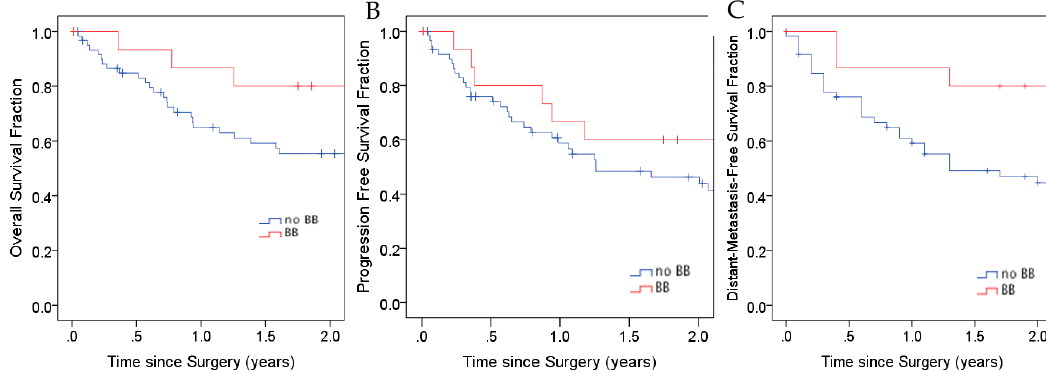
Figure 4. The effect of beta-blockers on patient clinical outcomes. Comparison of overall survival (OS), progression-free survival (PFS), and distant-metastasis-free survival (DMFS) between patients who took beta-blockers during treatment for non-small cell lung cancer (NSCLC) and those who did not. BB, beta-blocker.